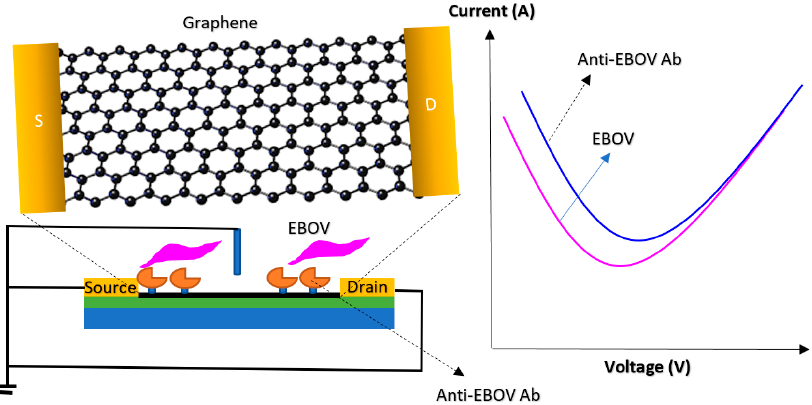
Figure 21. The illustration of the reduced graphene oxide (rGO)-FET immunosensor for Ebola Virus recognition and Surface modification and the conductance changes that occur upon attachment of the antigen to the antibody.